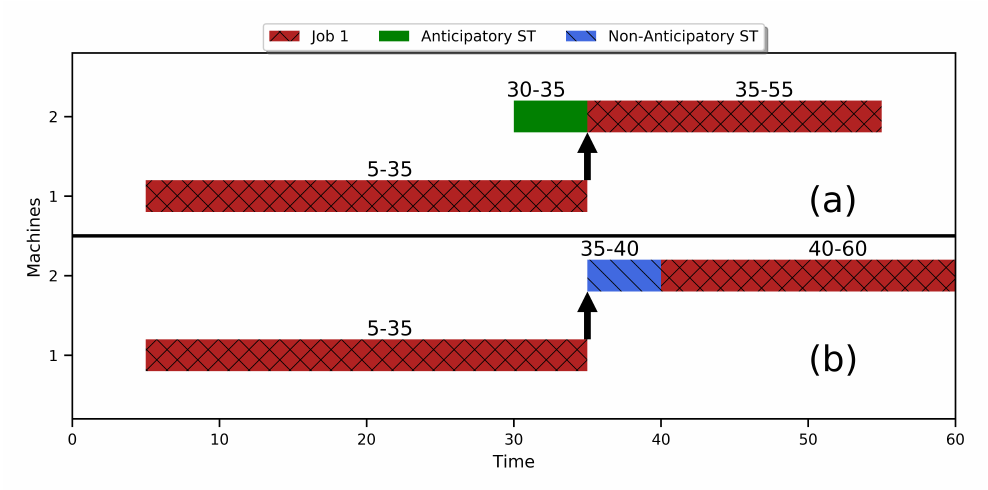
Figure 2. The anticipatory ( a ) and nonanticipatory ( b ) setups to process a job on a machine.